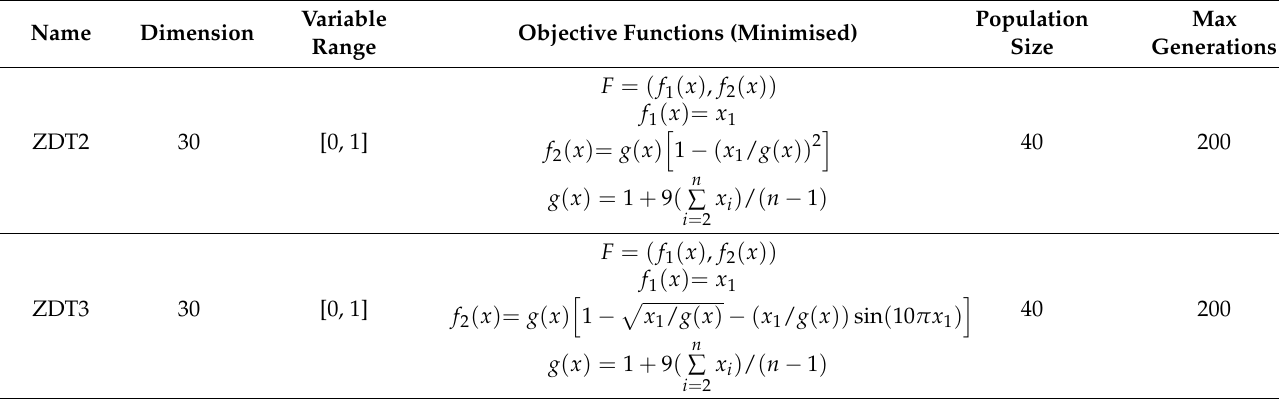
Table 1. Test function parameter configuration.